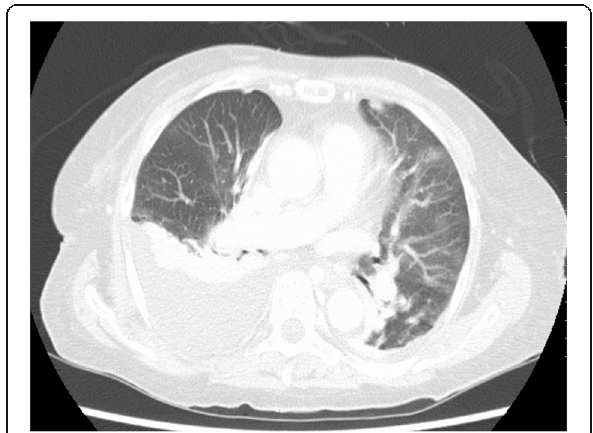
Fig. 2 Chest CT findings on POD 2. Right pleural effusion and bilateral pneumonia were confirmed by a chest CT